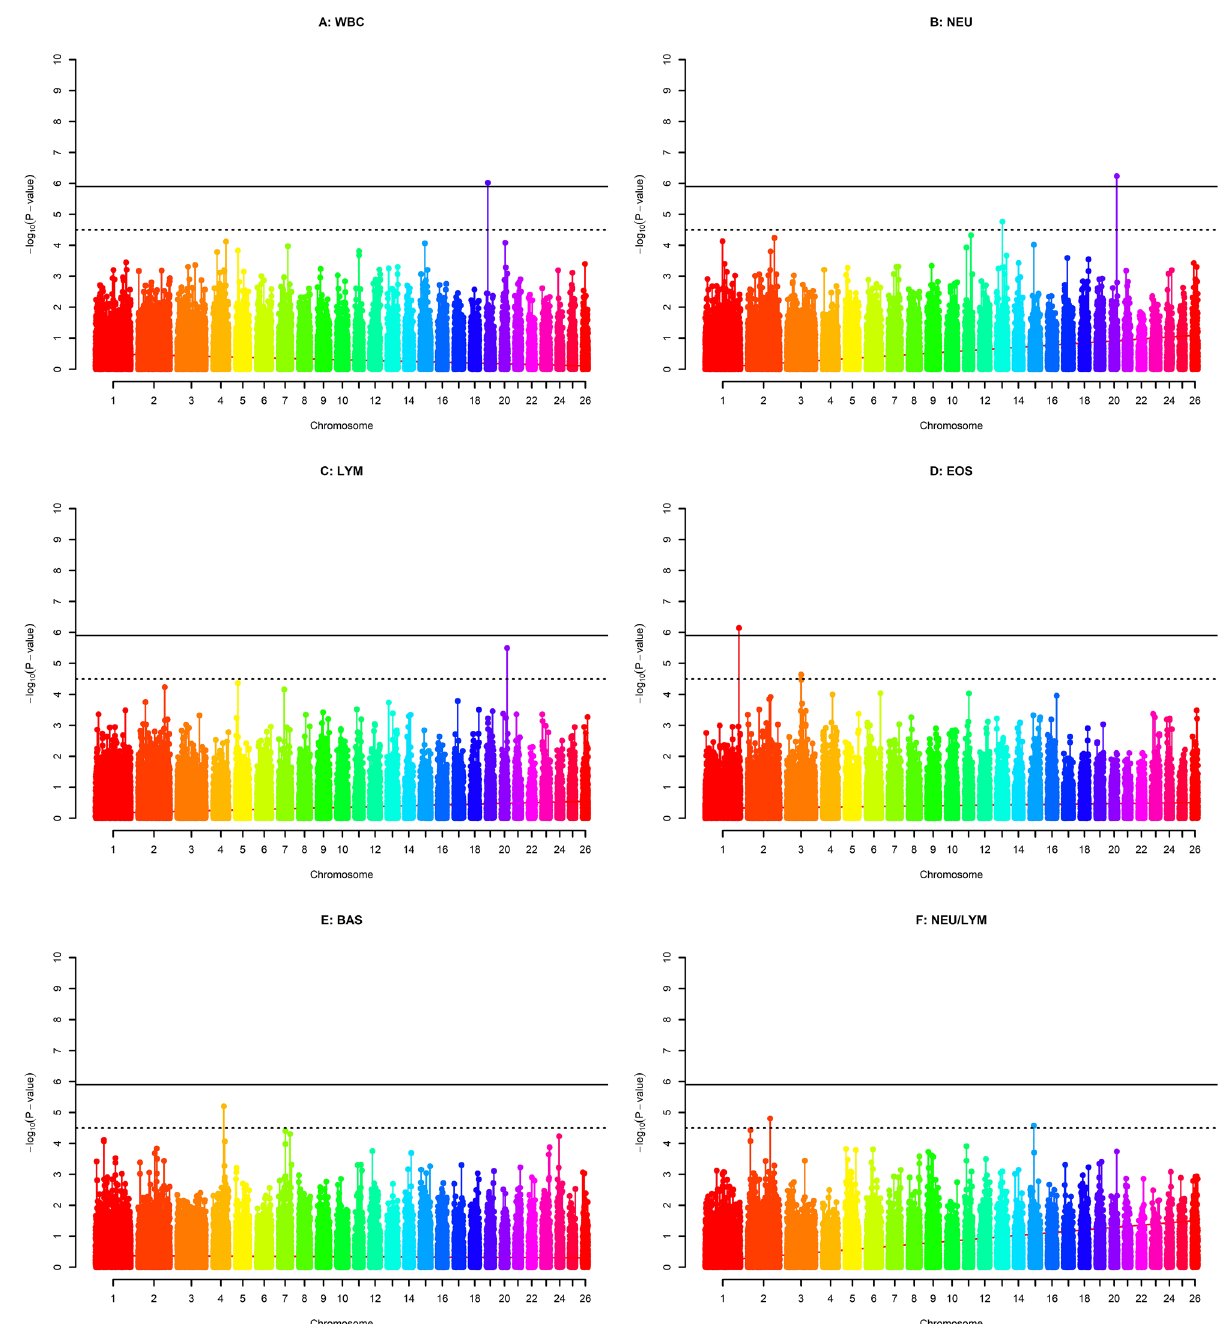
Figure 2. Manhattan plots of GWAS for leukocyte related traits. Red dashed lines (i.e., upper line) represent Bonferroni-corrected genome-wide significance level, while black dashed lines (i.e., lower line) are for Bonferroni-corrected chromosome-wide significance level. White blood cell count ( A ), neutrophils ( B ), lymphocytes ( C ), eosinophils ( D ), basophils ( E ) and neutrophils/lymphocytes ( F